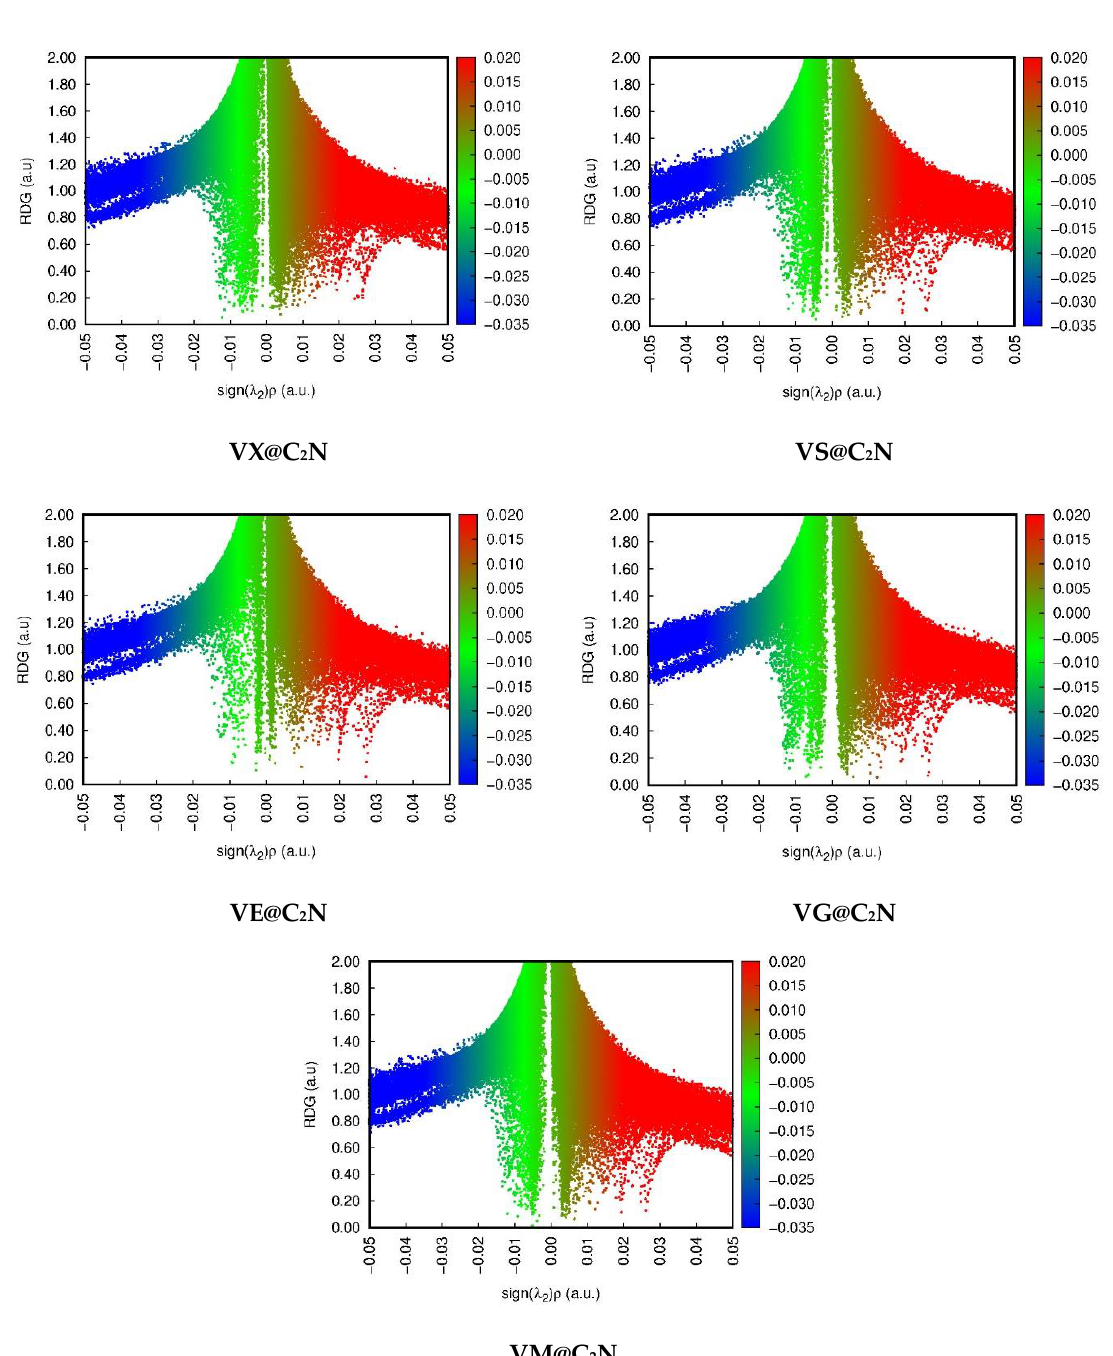
Figure 4. NCI 3D isosurfaces of optimized geometries of stable V-series@C 2 N complexes computed at M05-2X method (iso value 0.05 a.u.) here red color is for repulsive interaction, green color indi- cates weak van der Waal ’ s forces interactions, and blue color is for strong electrostatic interactions.